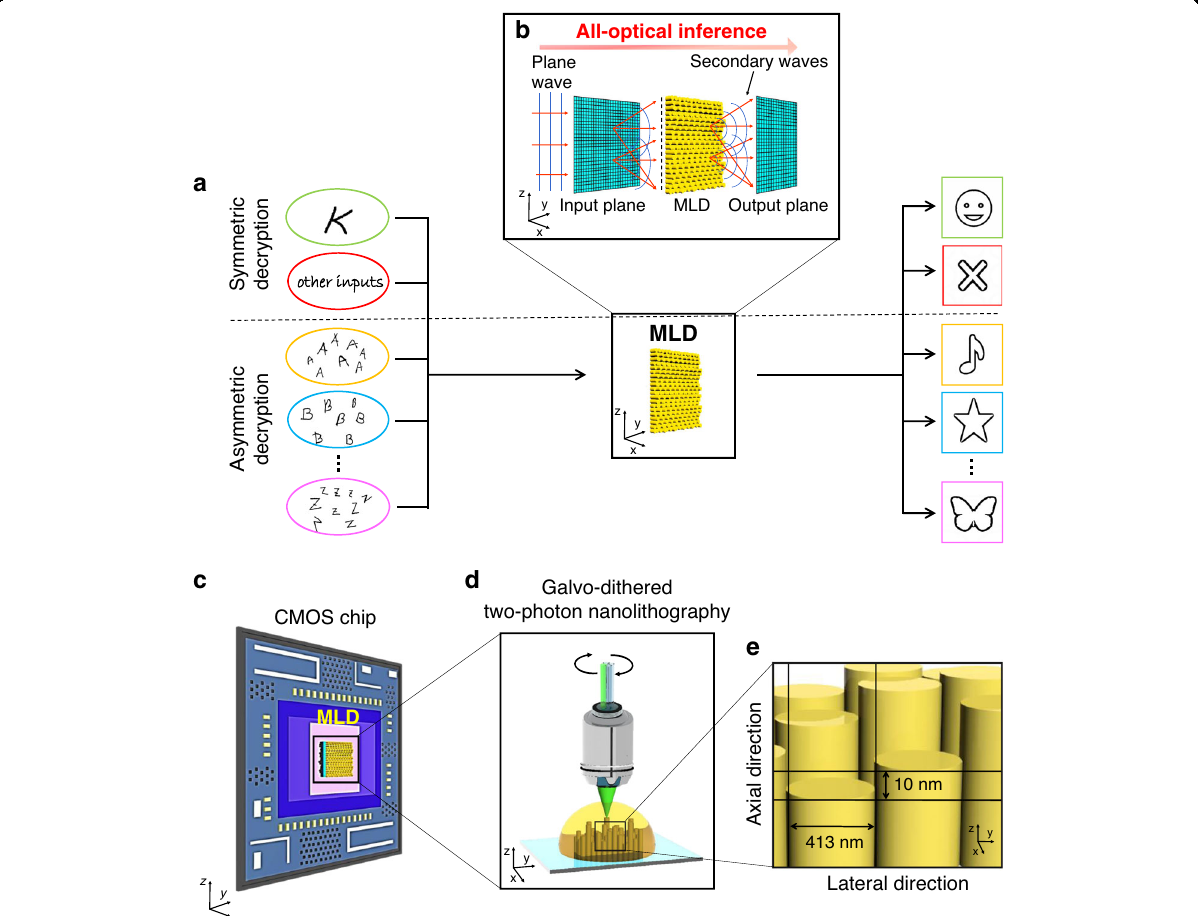
Fig. 1 All-optical machine learning decryptor for integration on CMOS. a Through computer machine learning training, the optical machine learning decryptor (MLD) acquires the capabilities of identifying a single decryption key (symmetric decryption, top) or entire classes of decryption keys (asymmetric decryption, bottom), and decoding a multitude of messages using a single decryptor element. b The decryption system can be considered a diffractive neural network for optical inference. Each layer of the network consists of N × N arti fi cial neurons, secondary sources of waves (details in Supplementary Methods). c Schematic of an MLD integrated with a CMOS chip. The nanoscale MLD is physically 3D printed by GD-TPN ( d ), a nanofabrication method that gives precise control over the MLD neuron dimensions in the lateral and axial directions ( e ), achieving axial nanostepping of 10